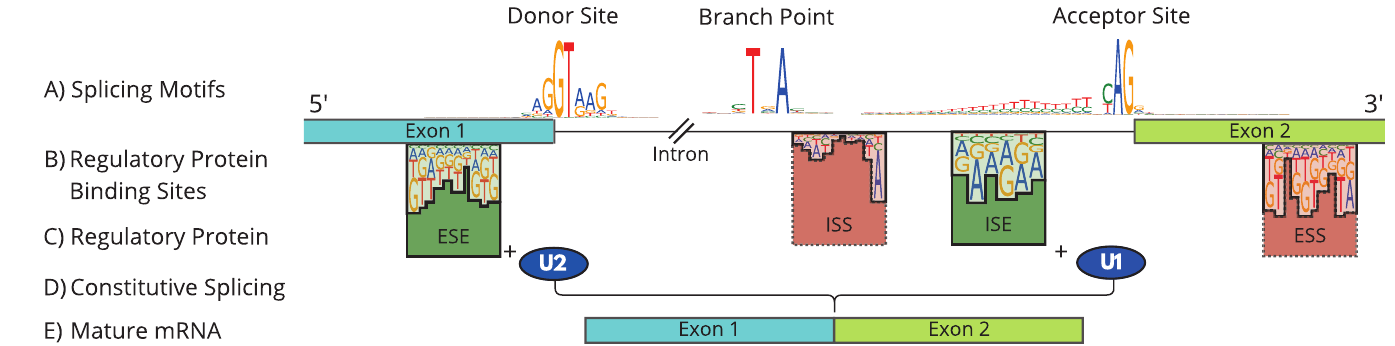
Fig 1. Schematic diagram of splicing process and major regulatory elements. (A) Frequency diagrams at splice sites reveal nucleotide sequence motifs for the acceptor and donor site. The branch point is located upstream of the acceptor. (B) Regulatory protein binding sites can occur anywhere around a splice site. (C) Regulatory protein bind to the motifs and excite or inhibit splicing. (D) The U1 and U2 snRNPs bind to the two splice sites and are attracted to or repelled by regulatory protein. The two junctions are joined to build (E) the mature mRNA that codes for a specific transcript. Branch point and protein binding motifs taken from [4–8].